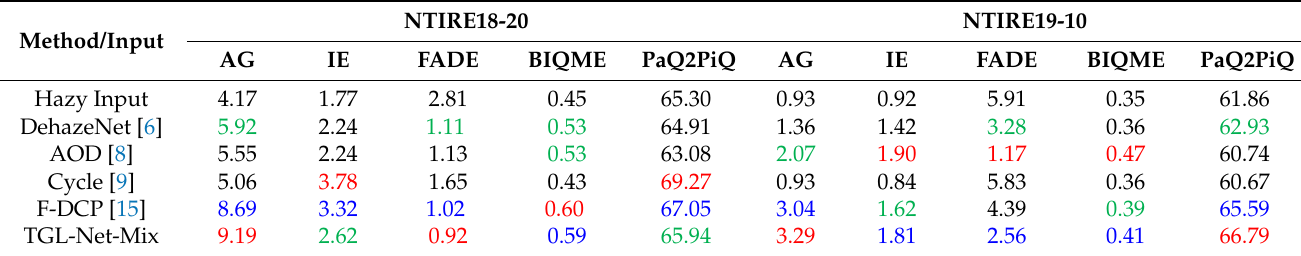
Table 4. Average values of non-reference measures in NTIRE